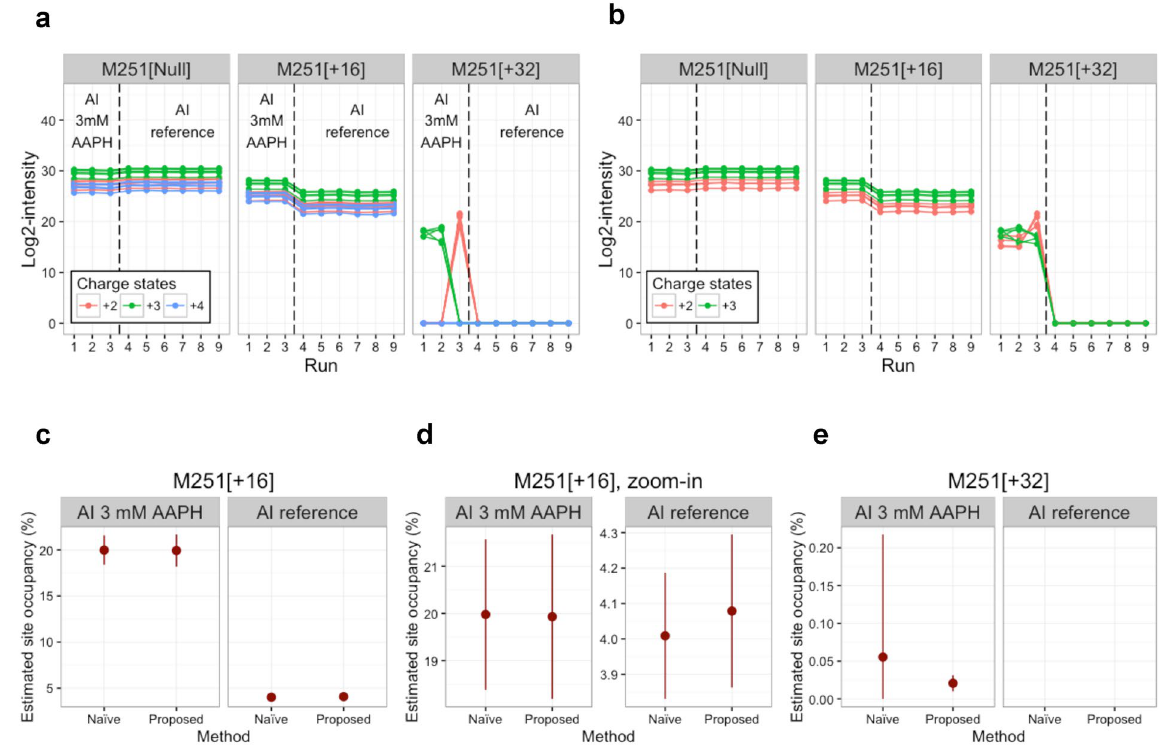
Figure 5. Goal 1: site occupancy estimation. Statistical characterization of site occupancy at site M251 in AI 3 mM AAPH and AI reference samples. ( a ) Profile plot of the features at site M251. There are three replicates in AI 3 mM AAPH (left) and six in AI reference (right). The features of the triply charged ions for the oxidative form M251[ + 32] are missing in the third replicate of the AI 3 mM AAPH sample while the features of the doubly charged ions are only observed in that replicate. ( b ) Profile plot of the features after feature selection and imputation of censored missing values by the proposed method. ( c ) Estimated site occupancies of the form M251[ + 16] with 95% confidence intervals by the naïve and proposed methods. ( d ) Expanded view of ( c ). ( e ) As in ( c ), but for the form M251[ +